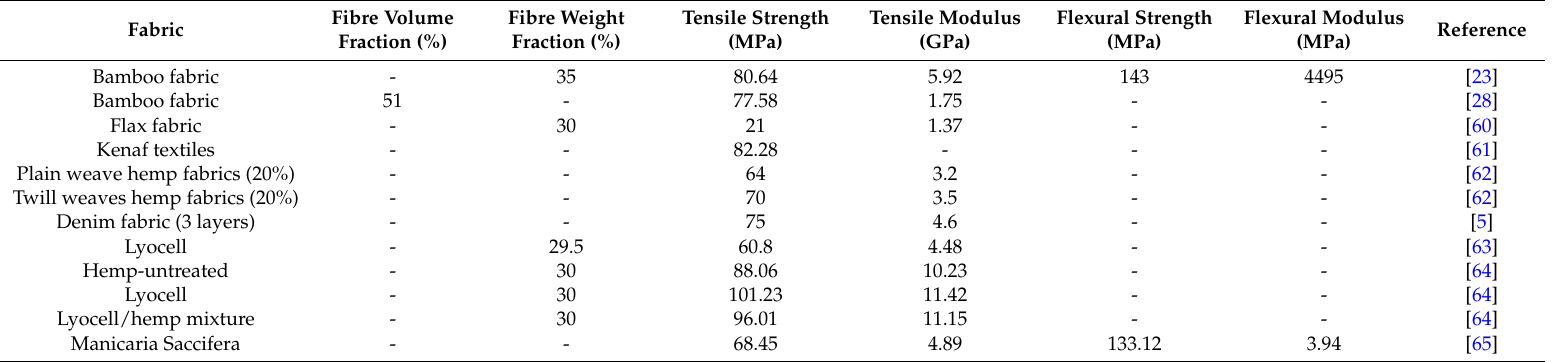
Table 5. Mechanical properties of natural fibre fabric-PLA